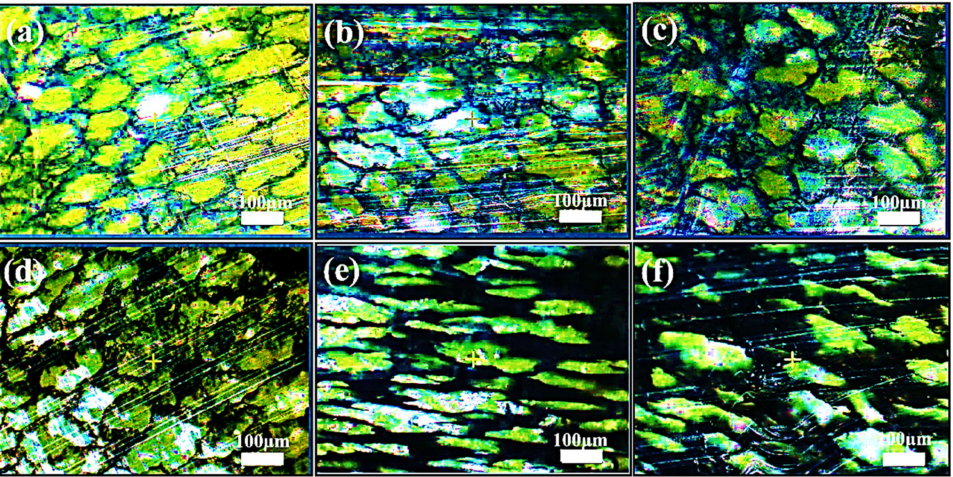
Figure 3. Optical microscopy images of the cross-sectional surface of UHMWPE/CCB composites: ( a ) UHMWPE/1-CCB 0.5 , ( b )UHMWPE/1-CCB 1 , ( c )UHMWPE/l-CCB 3 , ( d )UHMWPE/h-CCB 0.5 , ( e )UHMWPE/h-CCB 1 and ( f )UHMWPE/h-CCB 3